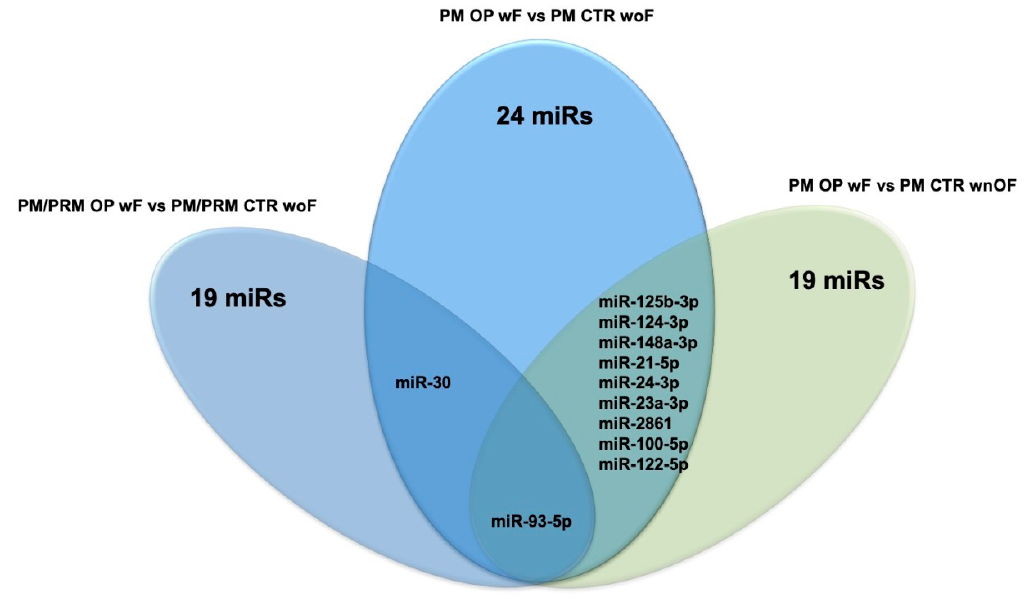
Figure 2. Venn diagram reports the potential biomarker miRs for fragility fracture risk. PM: post-menopause; OP: osteoporosis; PRM: pre-menopause; CTR: control; woF: without fracture; wF: with fracture; wnOF: with no-osteoporosis fracture.